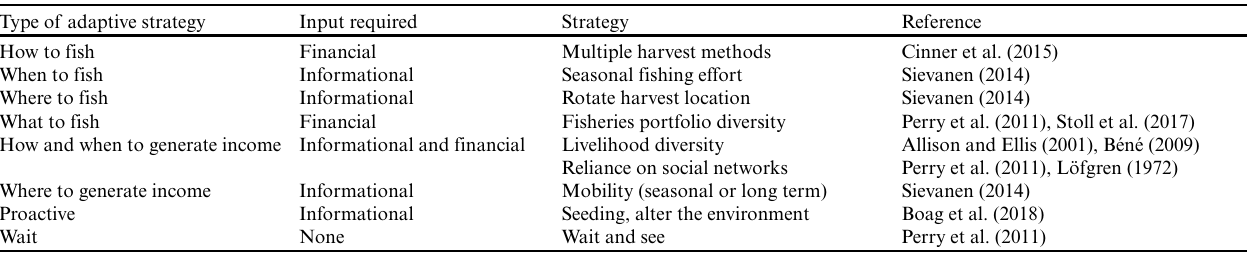
Table 1. Examples of adaptive strategies employed by small-scale fishers globally. Adaptive strategies often require financial and informational inputs from the fishers who employ them. Financial inputs require financial capital to purchase equipment such as boats, other motor vehicles, and fishing gear. Informational inputs include new knowledge and